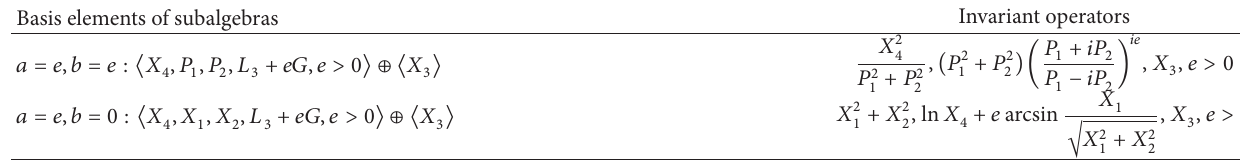
Table 13: Invariant operators of subalgebras of the type 𝐴 𝑎𝑏 4,6 ⊕ 𝐴 1 .